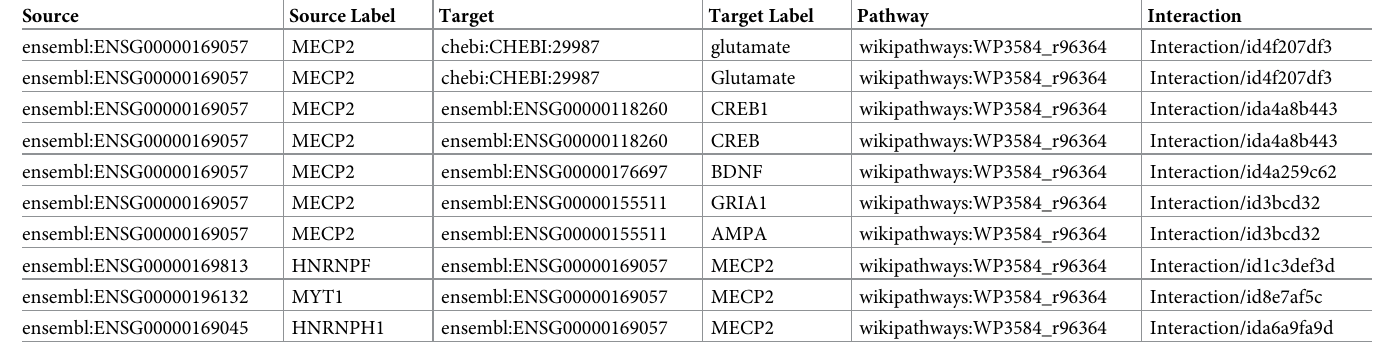
Table 8. MECP2 upstream and downstream targets. In the table a source node is shown with its label, as well as the target and its label. The pathway in which the interac- tion is found and the interaction id are also provided. Source